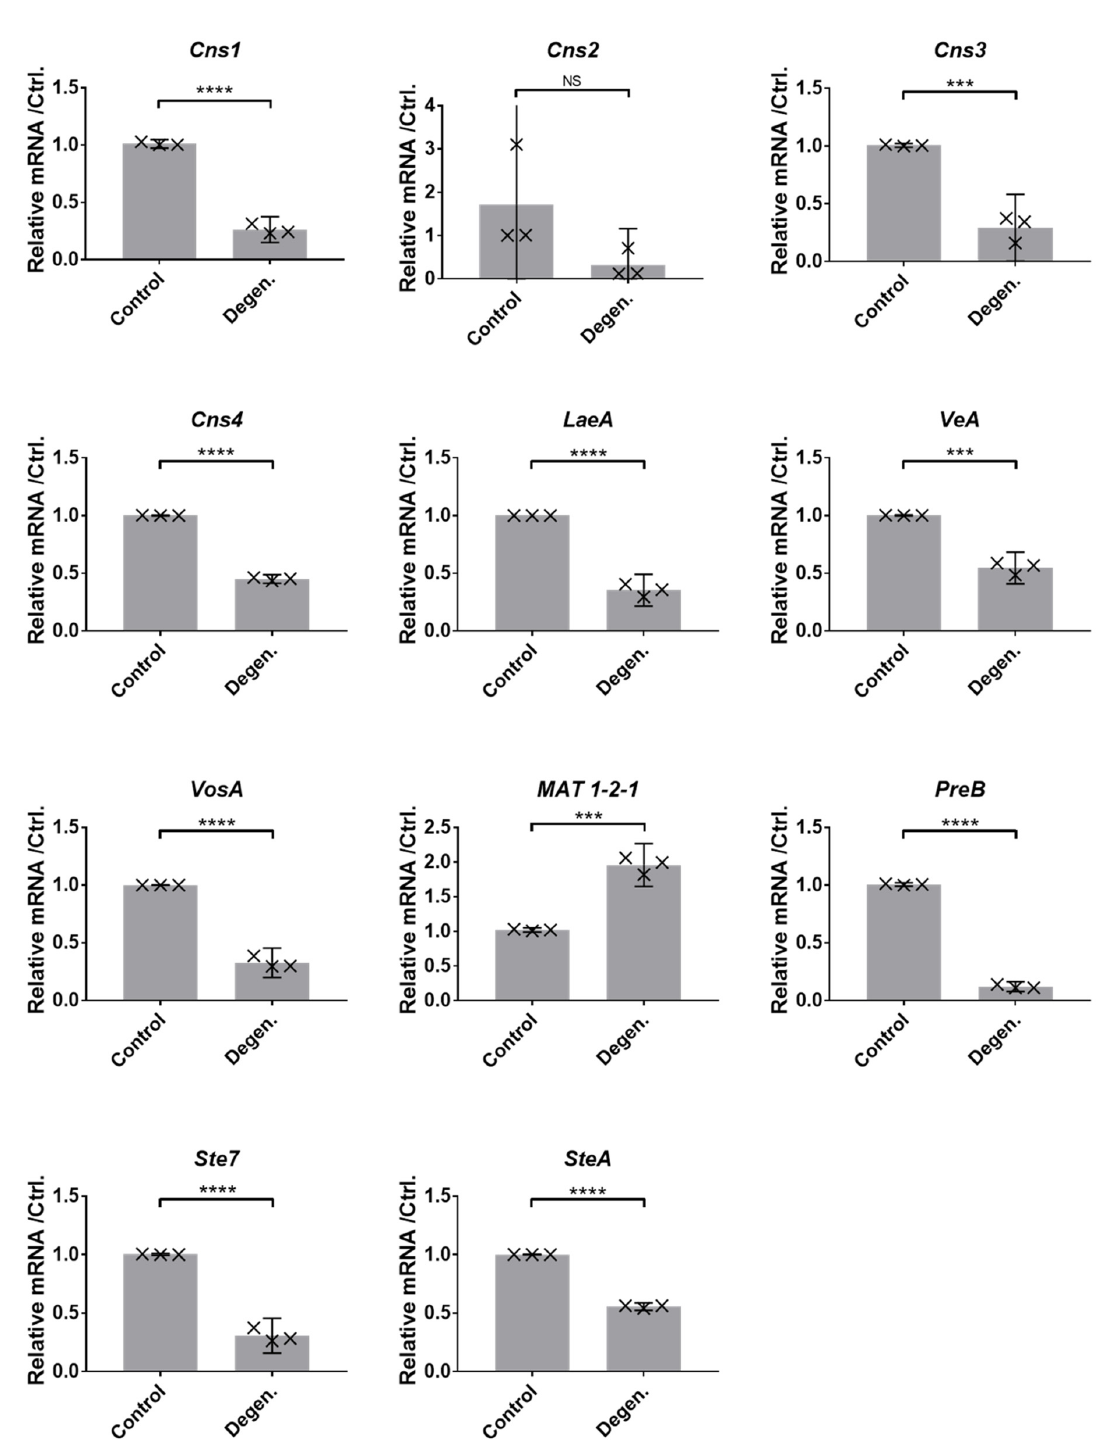
Figure 6. Relative mRNA levels of various genes of interest in parental control and degenerated CM2 strains cultured on PDA (potato dextrose agar). Gene expression was normalised against the average of four controls, GAPDH , Actin , Calmodulin and rps3 . Error bars show 95% confidence intervals, and labels show differences between means as calculated using t -tests. *** p < 0.001; **** p < 0.0001. Genes included are the cordycepin and pentostatin synthesis gene cluster ( Cns1-4 ), velvet and related genes ( LaeA , VeA , VosA ), or other sexual development-related genes ( MAT 1-2-1 , PreB , Ste7 , SteA ). Three biological replicates, with each point representing an average of three technical replicates are shown.